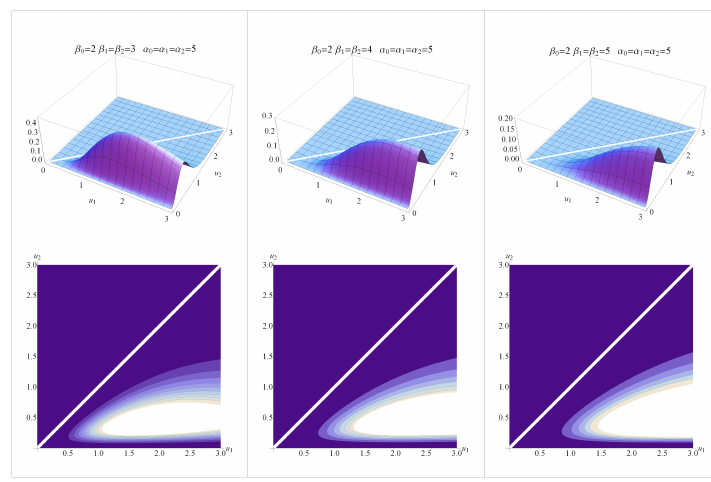
Figure 5. Equal sample sizes, increase in variance at time